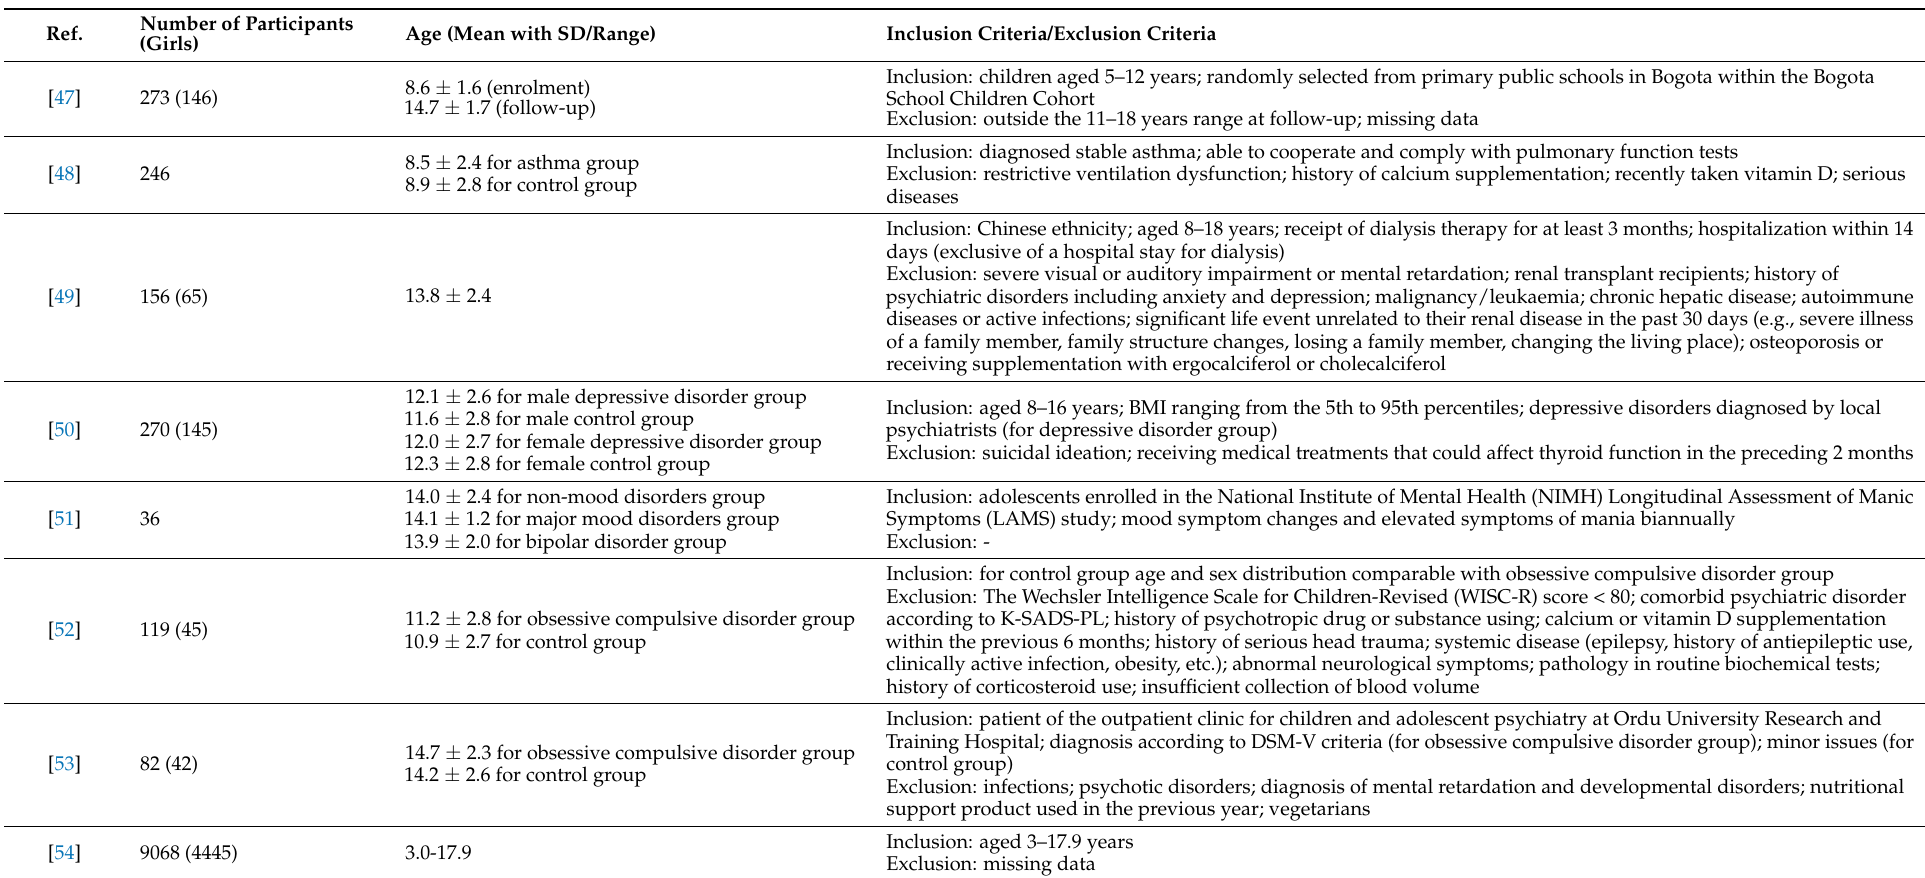
Table 7. The characteristics of the subjects of the included observational